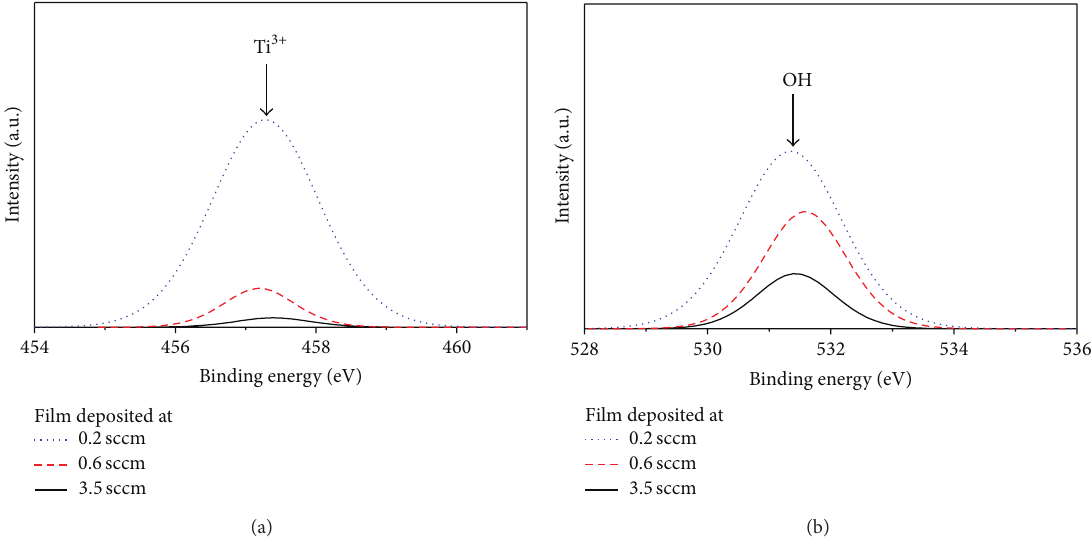
Figure 11: XPS spectra for (a) Ti2p 3/2 and (b) O1s core levels of the films deposited at (a) 0.2, (b) 0.6, and (c) 3.5